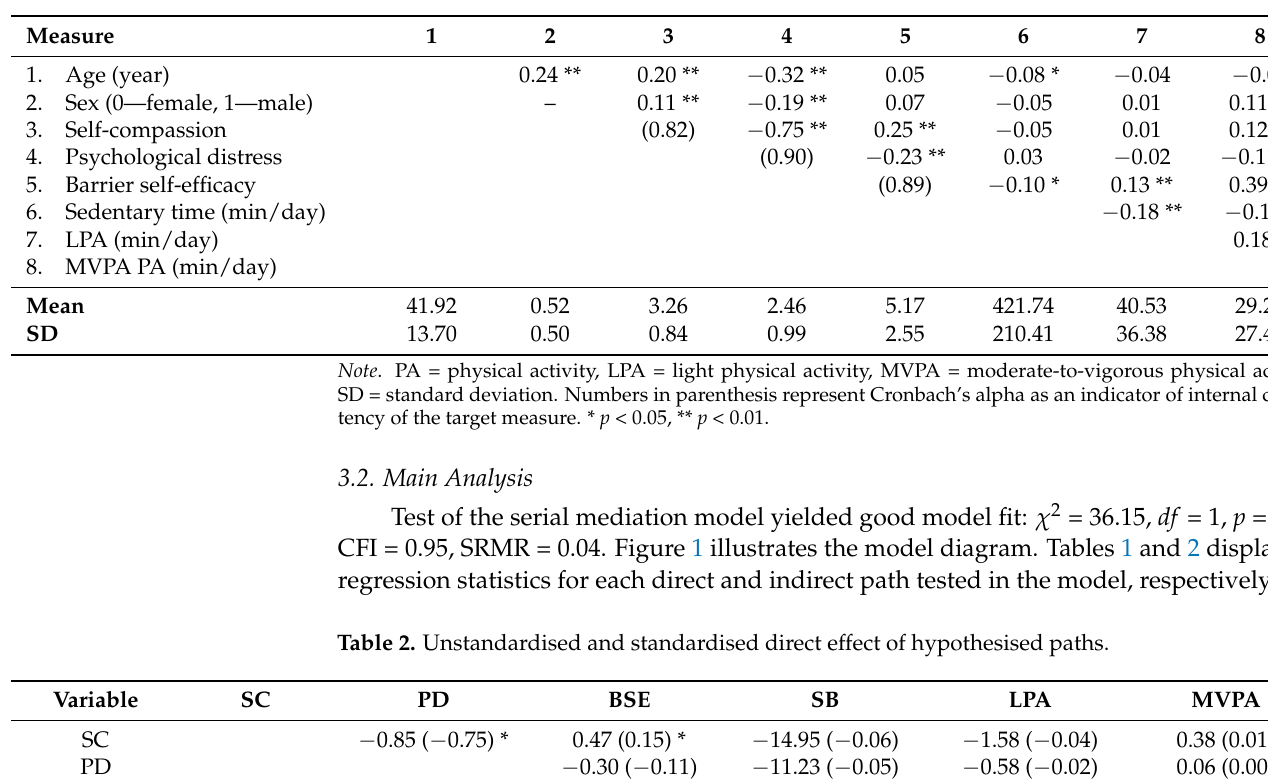
Table 1. Descriptive statistics and zero-order correlations for the study variables.